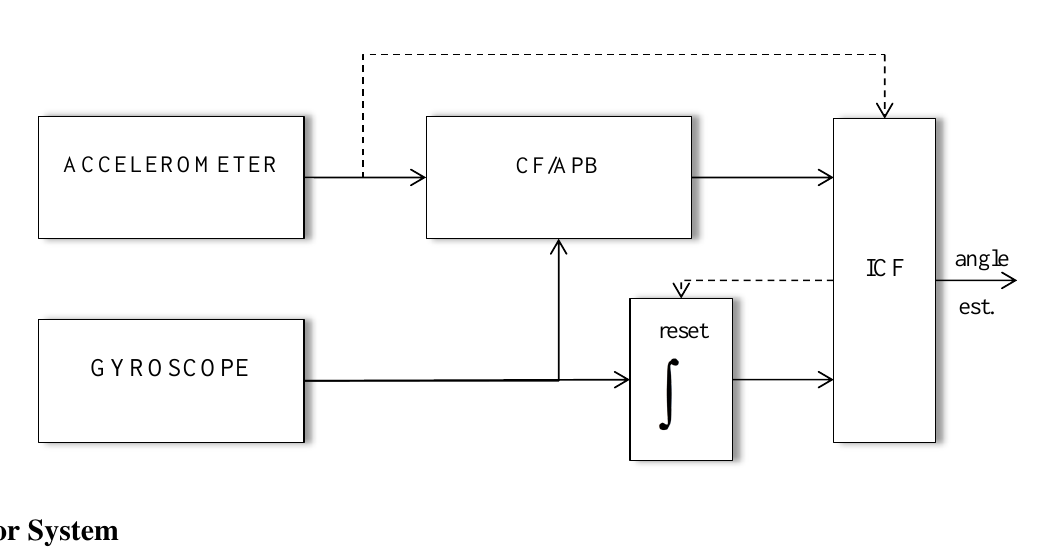
Figure 2. Schematic structure of the intelligent complementary filter (ICF) method.